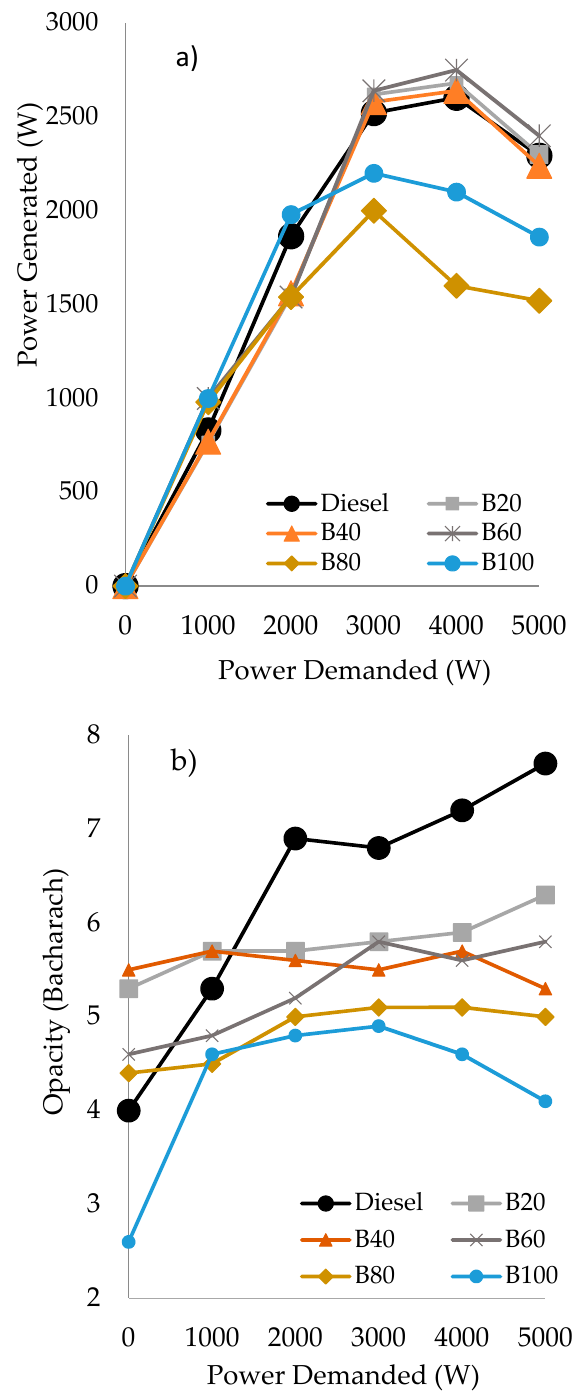
Figure 2. Power generated (in Watts), based on the power demanded (in Watts) ( a ) and opacity (in Bacharach) as a function of the power demanded ( b ) by the triple blends of diesel/gasoline/sunflower oil. Regarding the behavior of the triple blends with sunflower oil (Figure 2a), the B20, B40 and B60 blends exhibited a similar performance than fossil diesel. However, the blends with lower or no amount of diesel in the blend, i.e., B80 and B100, generate lower power values than fossil diesel, which is in agreement with their lower cetane number. Therefore, it seems that, at least, a minimum amount of diesel (40%) is required for a good performance of the triple